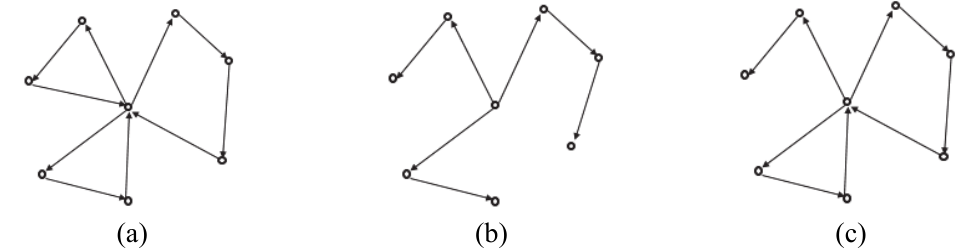
Fig. 1. Three heterogeneous variants of MTSP with a single depot' instead of 'Three distinct variants of MTSP with respect to single